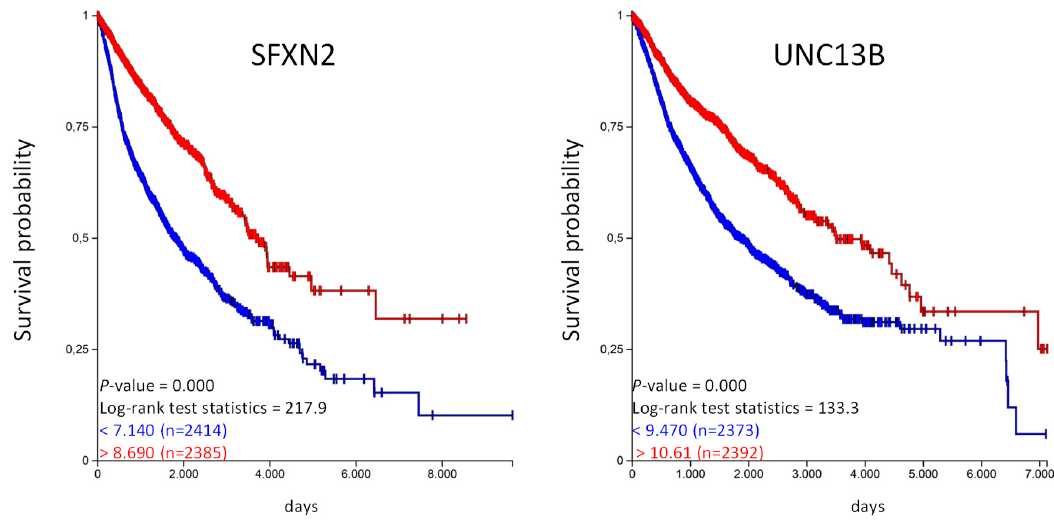
Figure 5. High SFXN2 and UNC13B expression is associated with longer overall survival in the PANCAN cohort. The TCGA-PANCAN cohort was queried for SFXN2 and UNC13B if they have an impact on survival probability. We filtered the data for primary tumor samples and generated Kaplan–Meier plots using the quartiles of gene expression level to separate high (red) and low (blue) expression level.